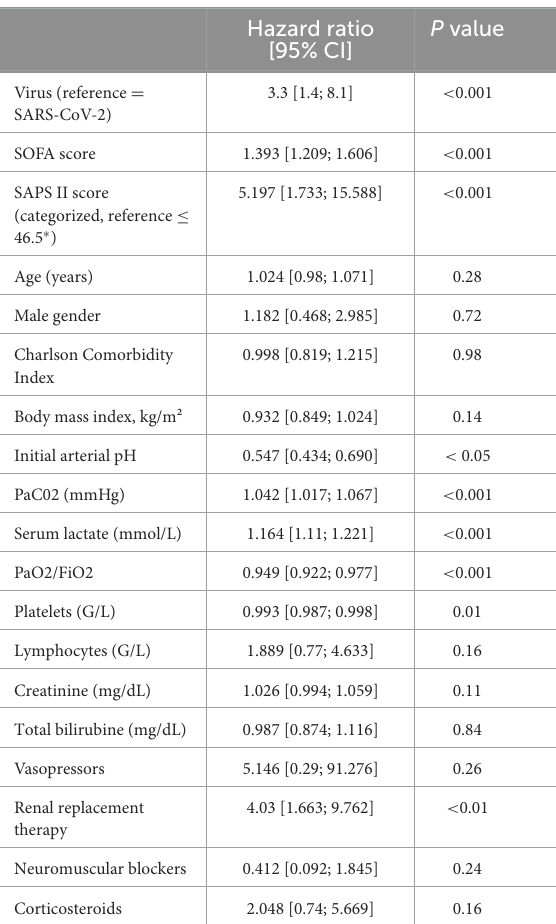
TABLE 4 Predictive factors of mortality (multivariate Cox model) – SOFA score considered.